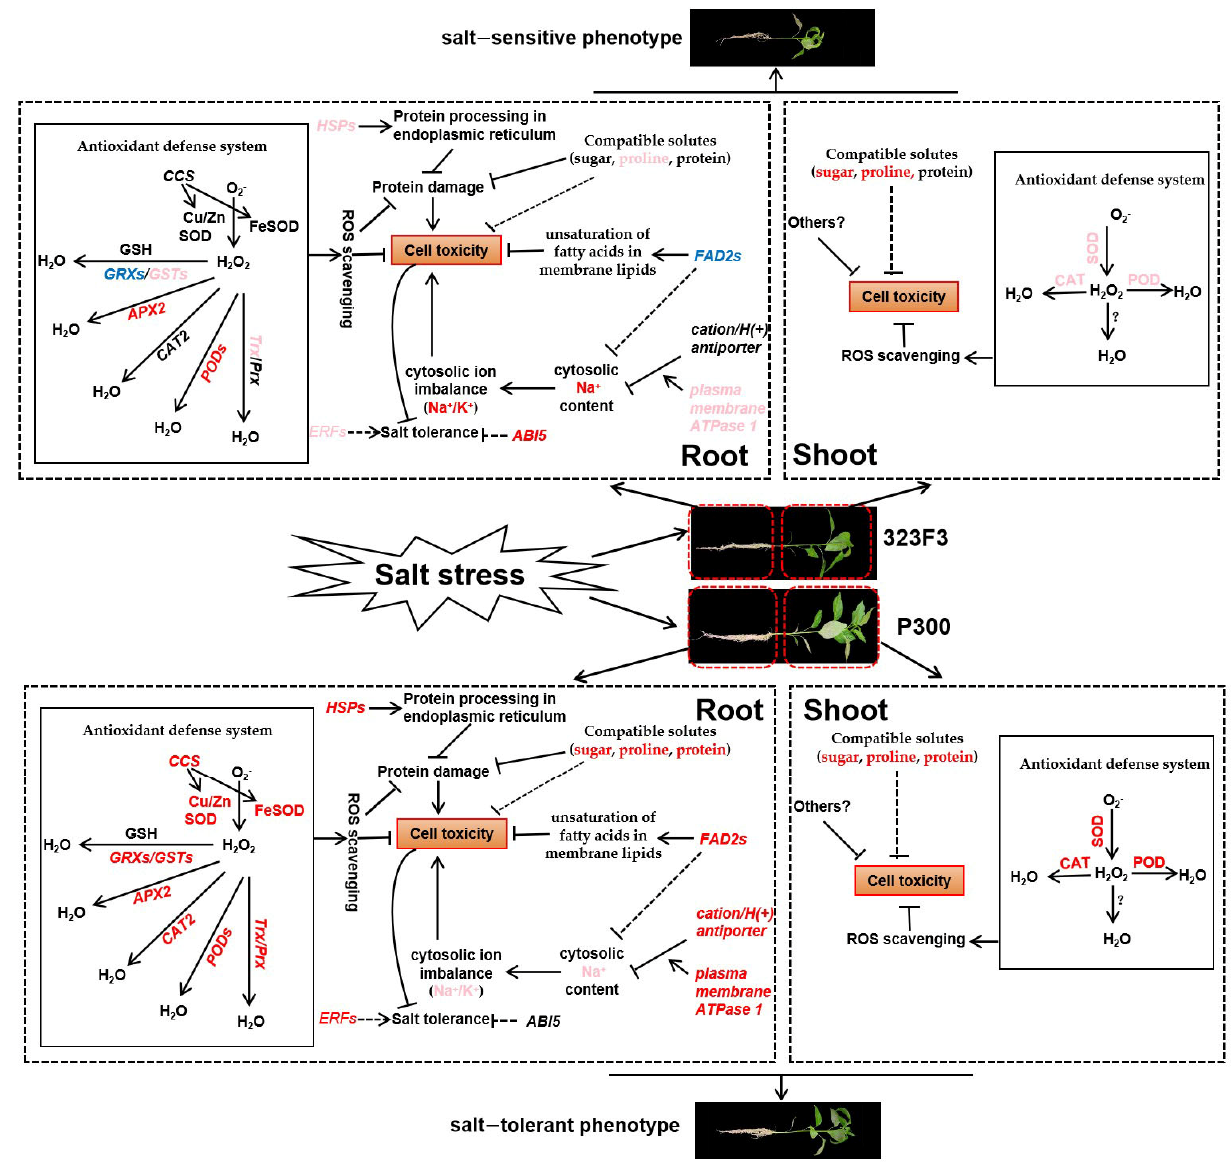
Figure 11. Proposed model illustrating the main salt tolerance mechanisms in seedlings of the two contrasting pepper genotypes (the salt ‐ tolerant genotype P300 and the salt ‐ sensitive genotype 323F3). Red fonts indicate strong up ‐ regulation, pink fonts indicate weak up ‐ regulation, green fonts indicate down ‐ regulation when exposed to salinity in the two genotypes compared with their controls.